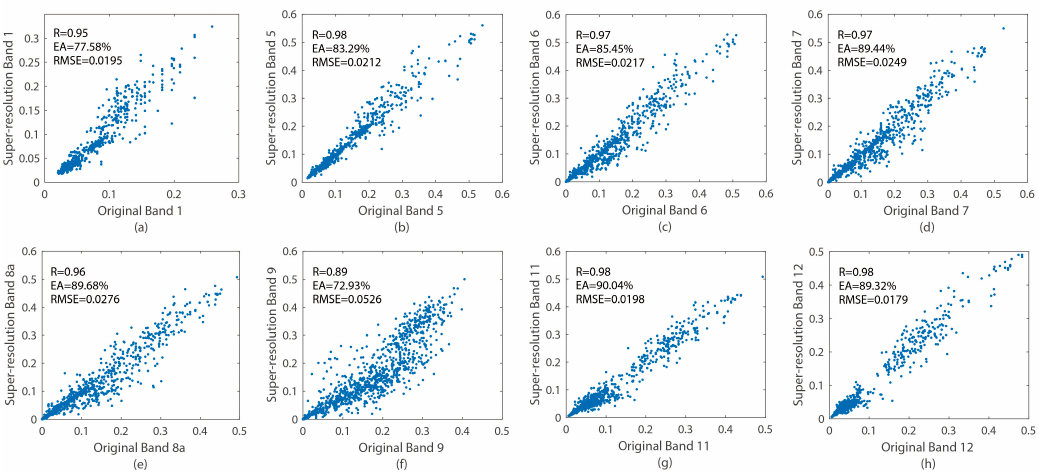
Figure 5. Reflectance consistency analysis of the super-resolution image and the original image. The X -axis is the original image reflectivity value, and the Y -axis is the super-resolution image reflectivity value.